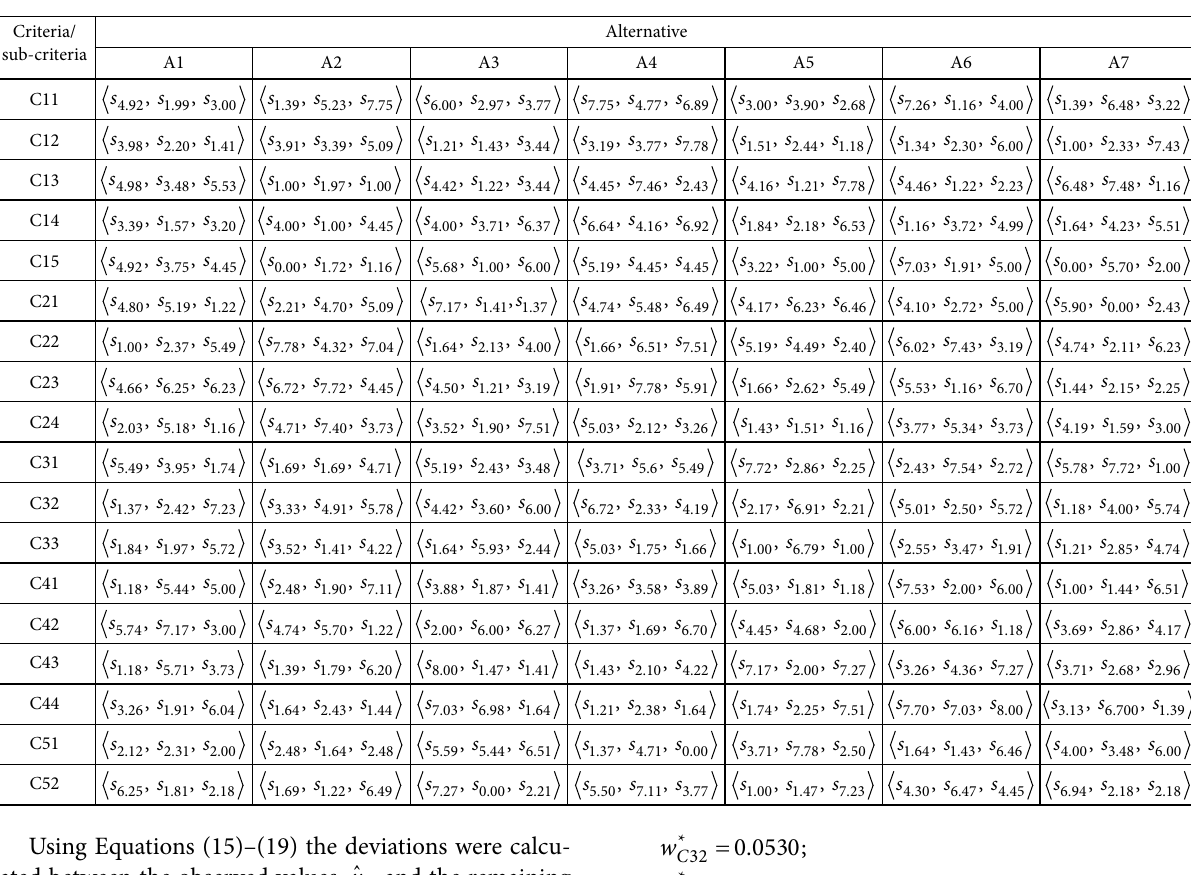
Table 4. Aggregated normalized initial decision